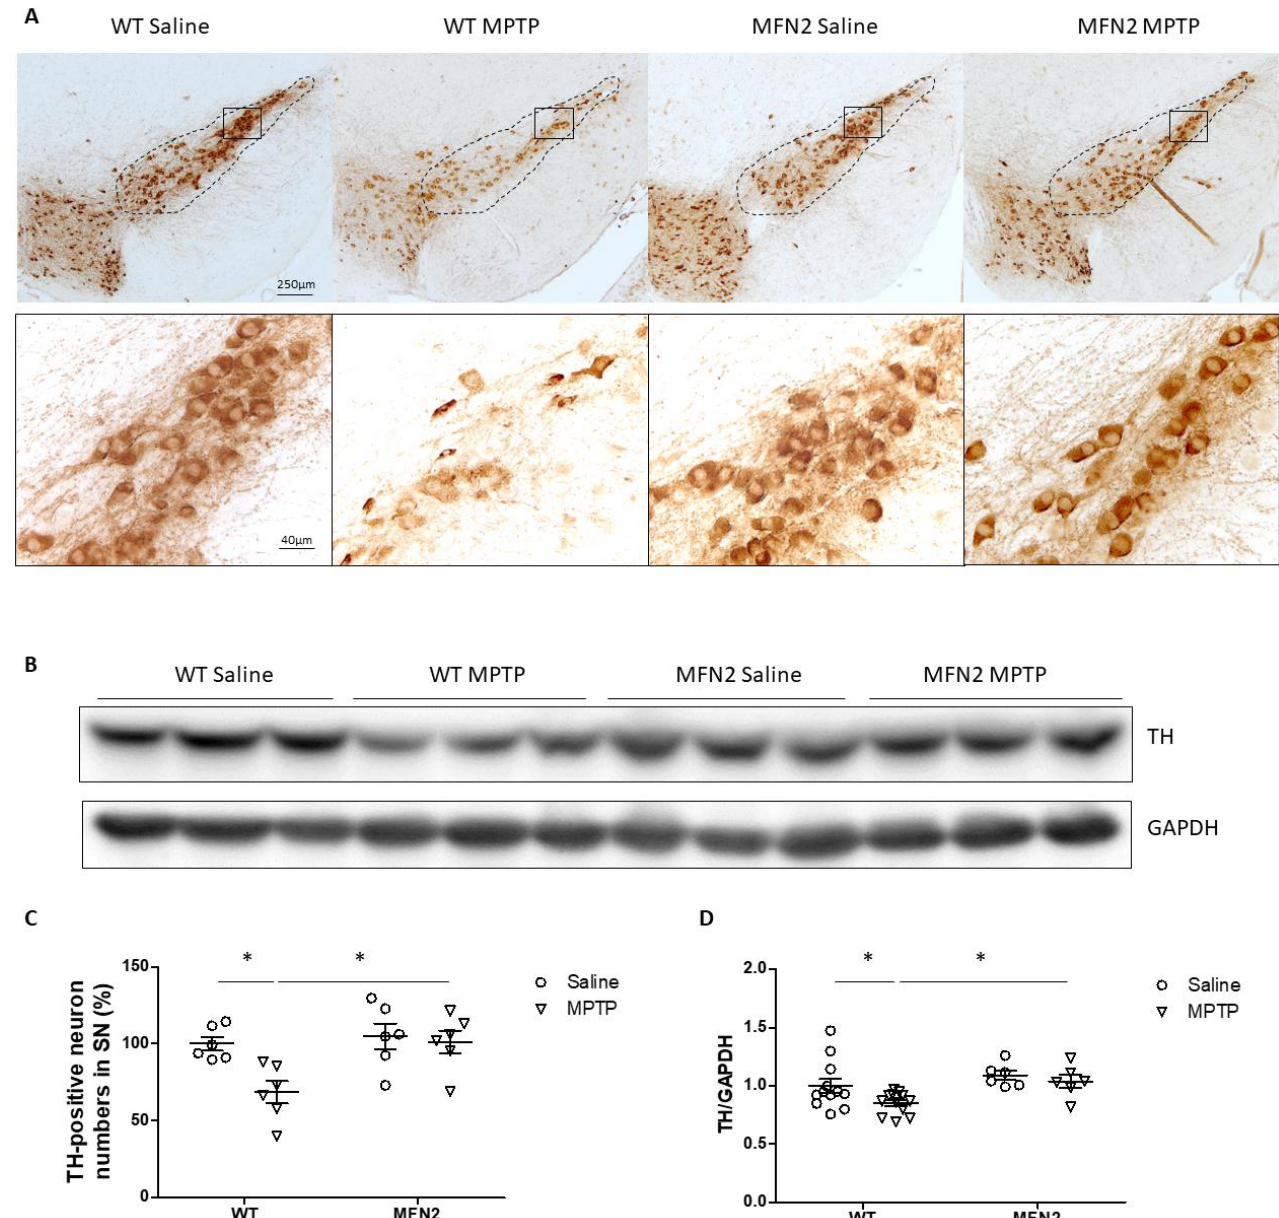
Figure 2. Mfn2 overexpression protected DA neurons from MPTP-induced degeneration in the SN. Seven days after the last injection, the mice were killed and half brains were fixed for tyrosine hydroxylase (TH) immunostaining. Representative pictures of dopaminergic neurons ( A ) in the SNpc area (dashed line) and quantification of relative neuronal numbers in the SN ( C ) are shown. The ventral midbrain was isolated from the other half brains and used for immunoblots ( B ). Quantification of relative TH protein levels in the ventral midbrain is shown ( D ). ( n = 5–6/group; * p < 0.05 compared to the control) .